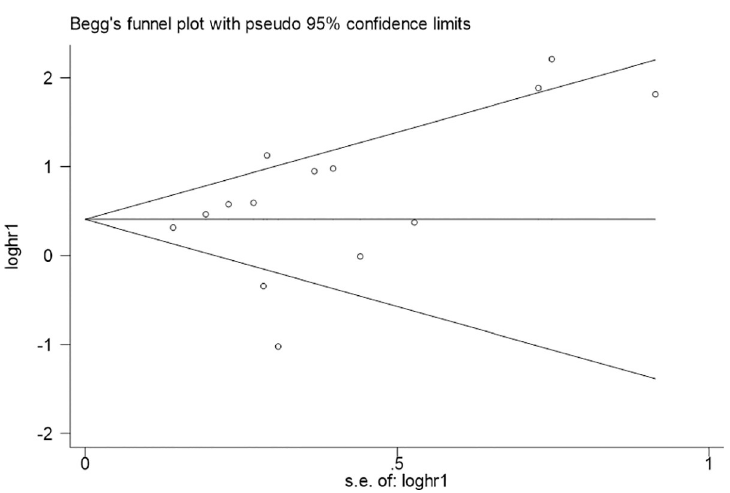
Fig 12. Begg’s funnel plot analysis of potential publication bias for